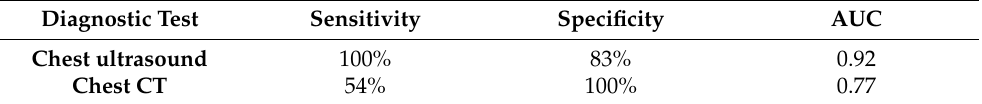
Table 5. Sensitivity, Specificity, AUC-ROC analysis of Chest US and Chest CT scan vs. gold standard MT.